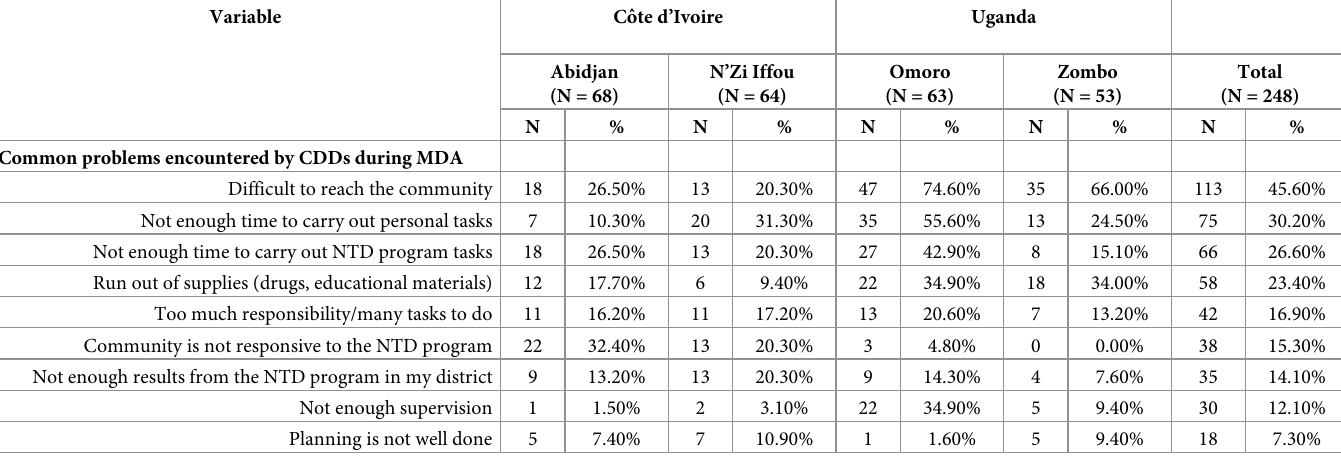
Table 7. Distribution method and reported issues encountered by CDDs, by